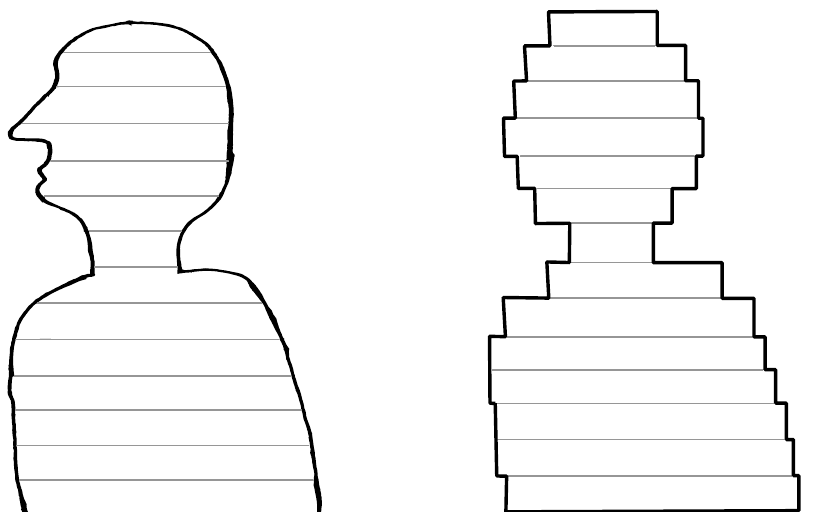
Figure 8. Slicing scheme for flat layers in additive manufacturing. Model with marked layers ( left ) and derived layer model ( right ).